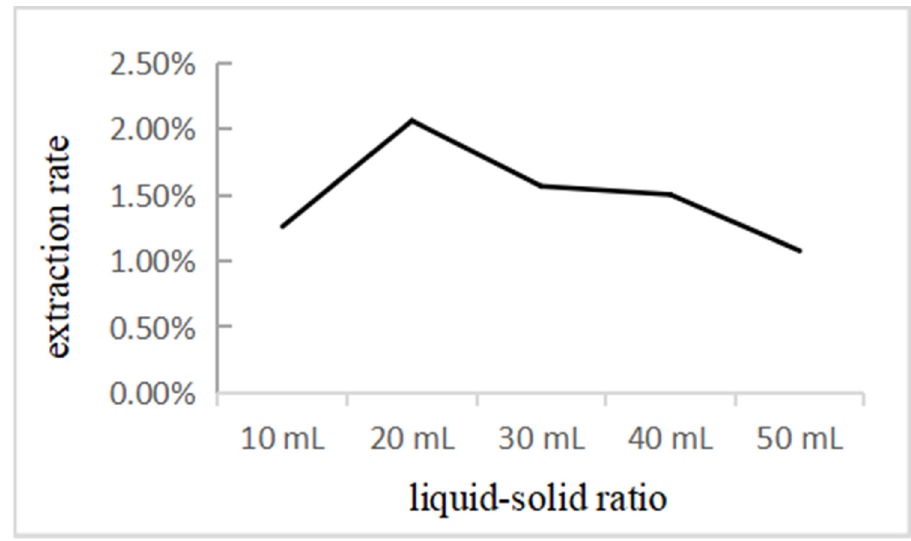
Figure 2. Effect of liquid–solid ratio on the extraction yield of coumarins.